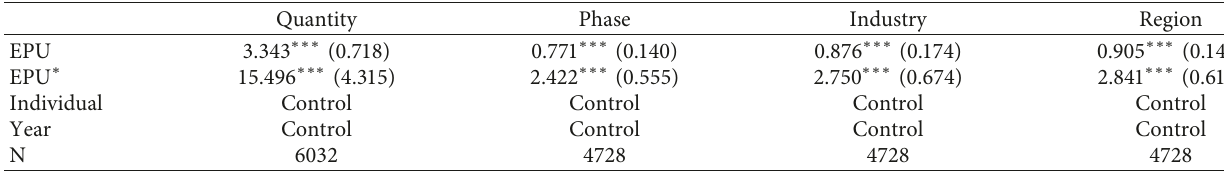
Table 7: Robustness test for EPU ∗ index replacement.